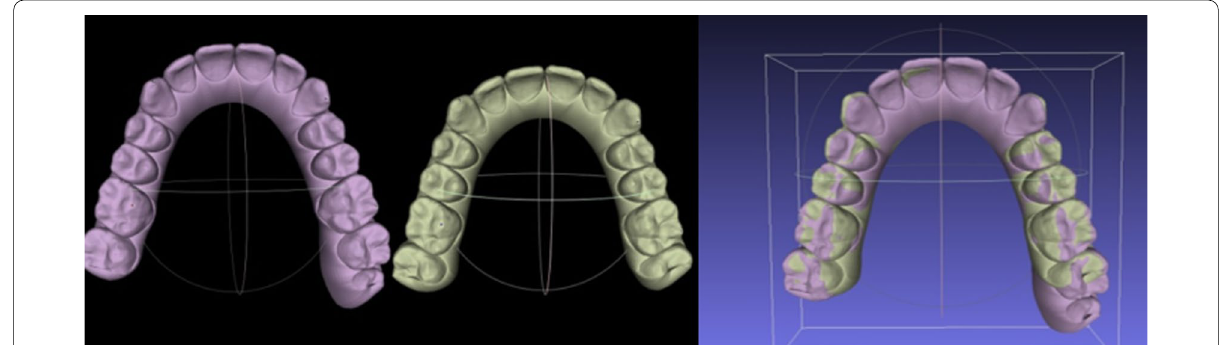
Fig. 1 Digital casts superimposition: pre-treatment, real post-treatment and planned post-treatment (Meshlab